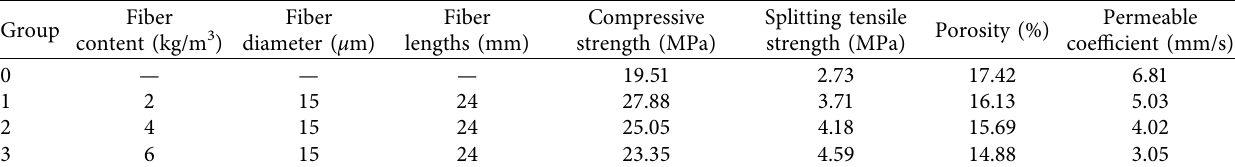
Figure 14: Microstructure of fber-cement interface with diferent lengths. (a) Fibers change the direction of fracture development. (b) Fibers are stressed to resist crack development. (c) Te fbers are strained and pulled apart. (d) Te fbers are interrupted during the mixing Table 6: Test results of pervious concrete with diferent content of basalt fber.